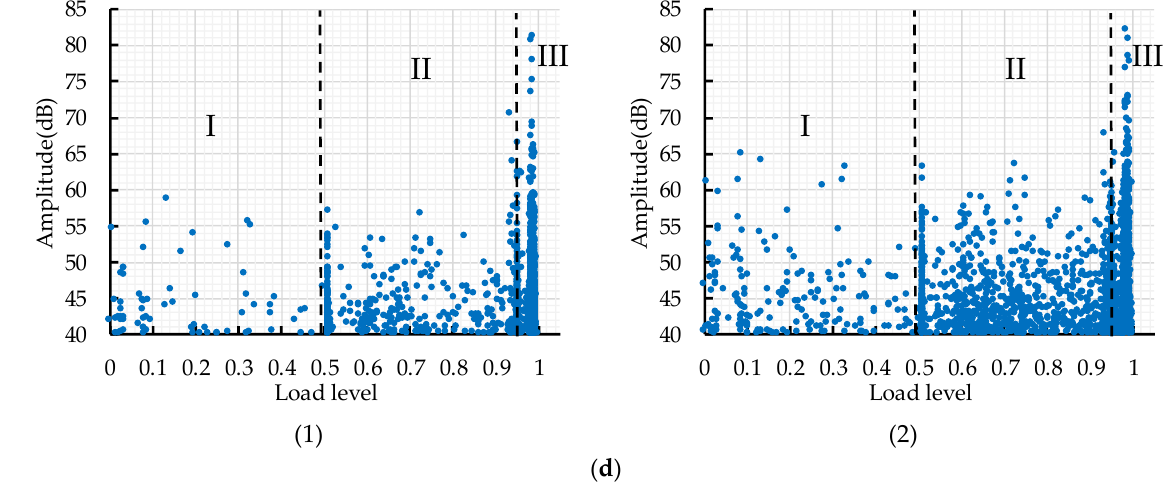
Figure 8. The distribution of AE amplitude: ( a ) RPC; ( b ) SBRPC-1; ( c ) SBRPC-3; ( d ) SBRPC-5.